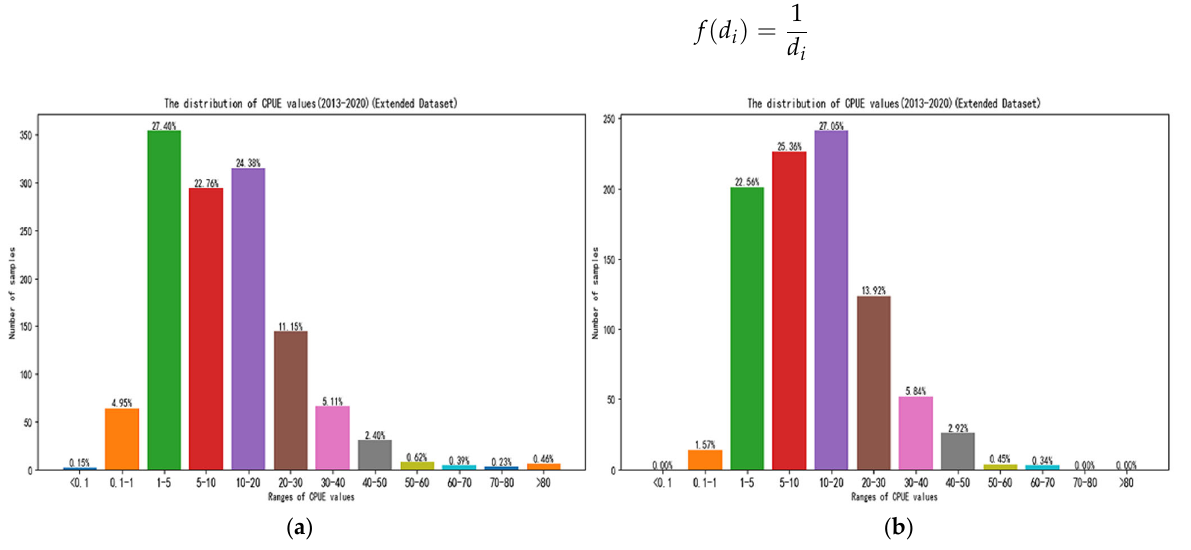
Figure 1. ( a ) The distribution of CPUE values of the fisheries’ datasets. ( b ) The distribution of CPUE values of the fisheries’ datasets after deletion of outliers.